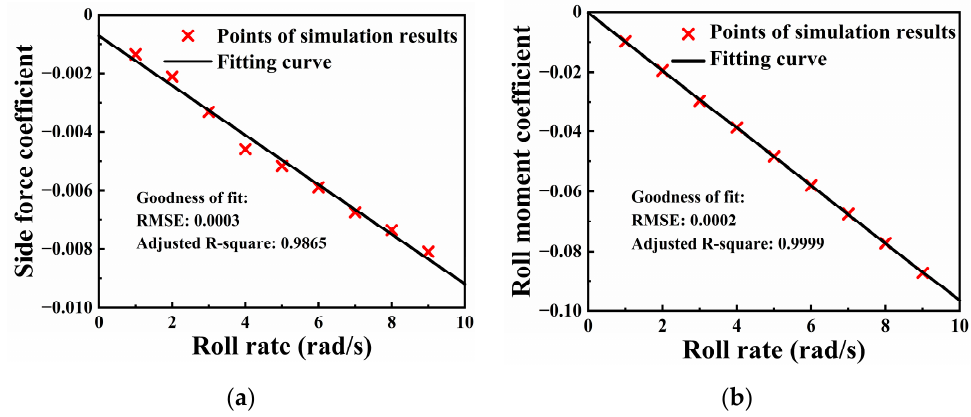
Figure 8. Curve fitting of aerodynamic coefficients versus the roll rate: ( a ) side force; ( b ) roll moment. The side force, roll moment and yaw moment coefficients versus yaw rate are pre- sented in Figure 9. With the increase in yaw rate, the side force coefficient and yaw moment coefficient decrease linearly, while the roll moment coefficient increases linearly.